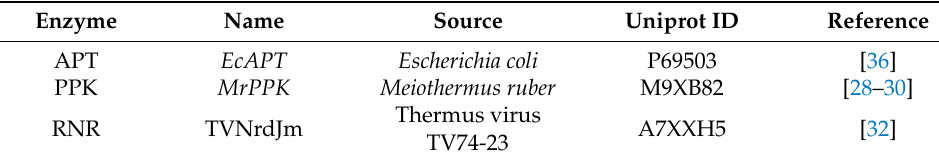
Table 1. Nucleotide-modifying enzymes used in this